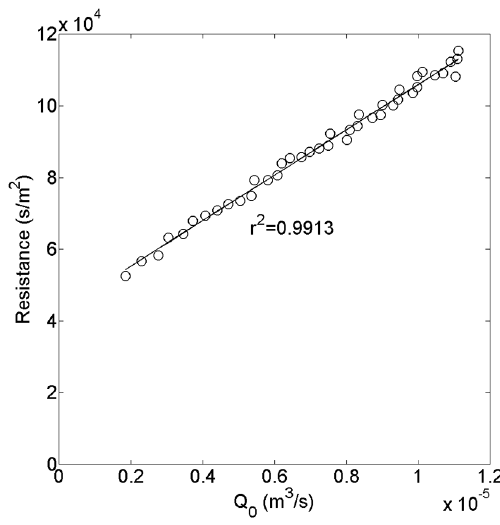
Figure 3. Average resistance to flow versus injection flow rate Q 0 (m 3 s − 1 ). The circles represent the experimental values, the straight line represents the resistance to flow evaluated by Eq.